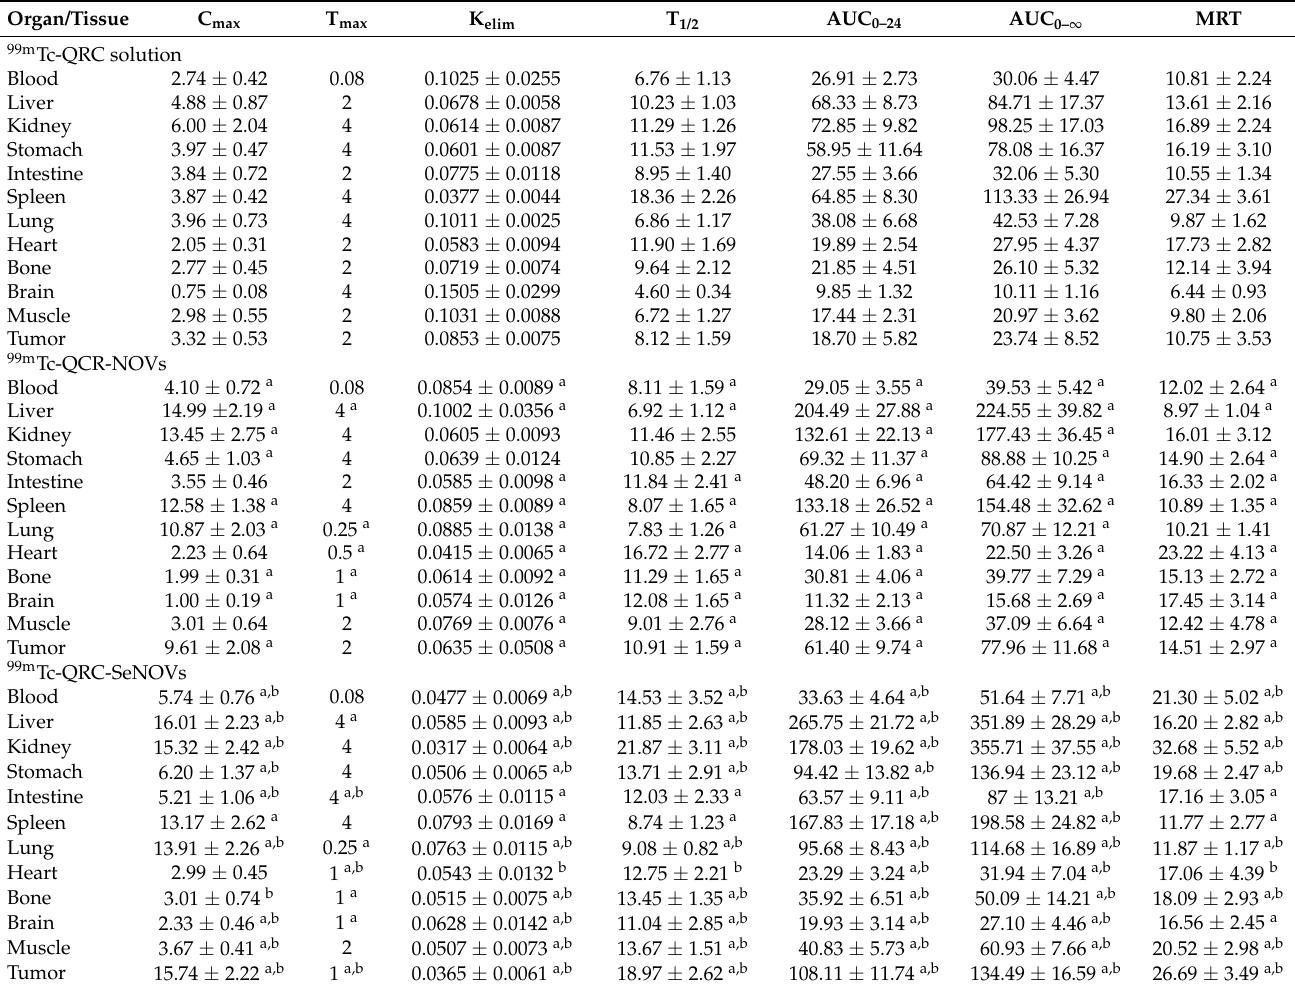
Table 5. Pharmacokinetics parameters of QRC tissue distribution after i.v. administrations of 99m Tc- QRC solution, 99m Tc-QRC-NOVs, and 99m Tc-QRC-SeNOVs to Ehrlich tumor-bearing